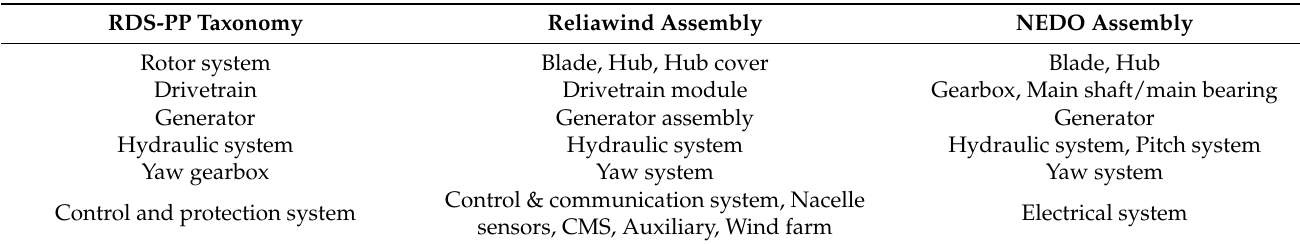
Table 3. Conversion of taxonomy used for data collection from Reliawind and NEDO database to RDS-PP. RDS-PP